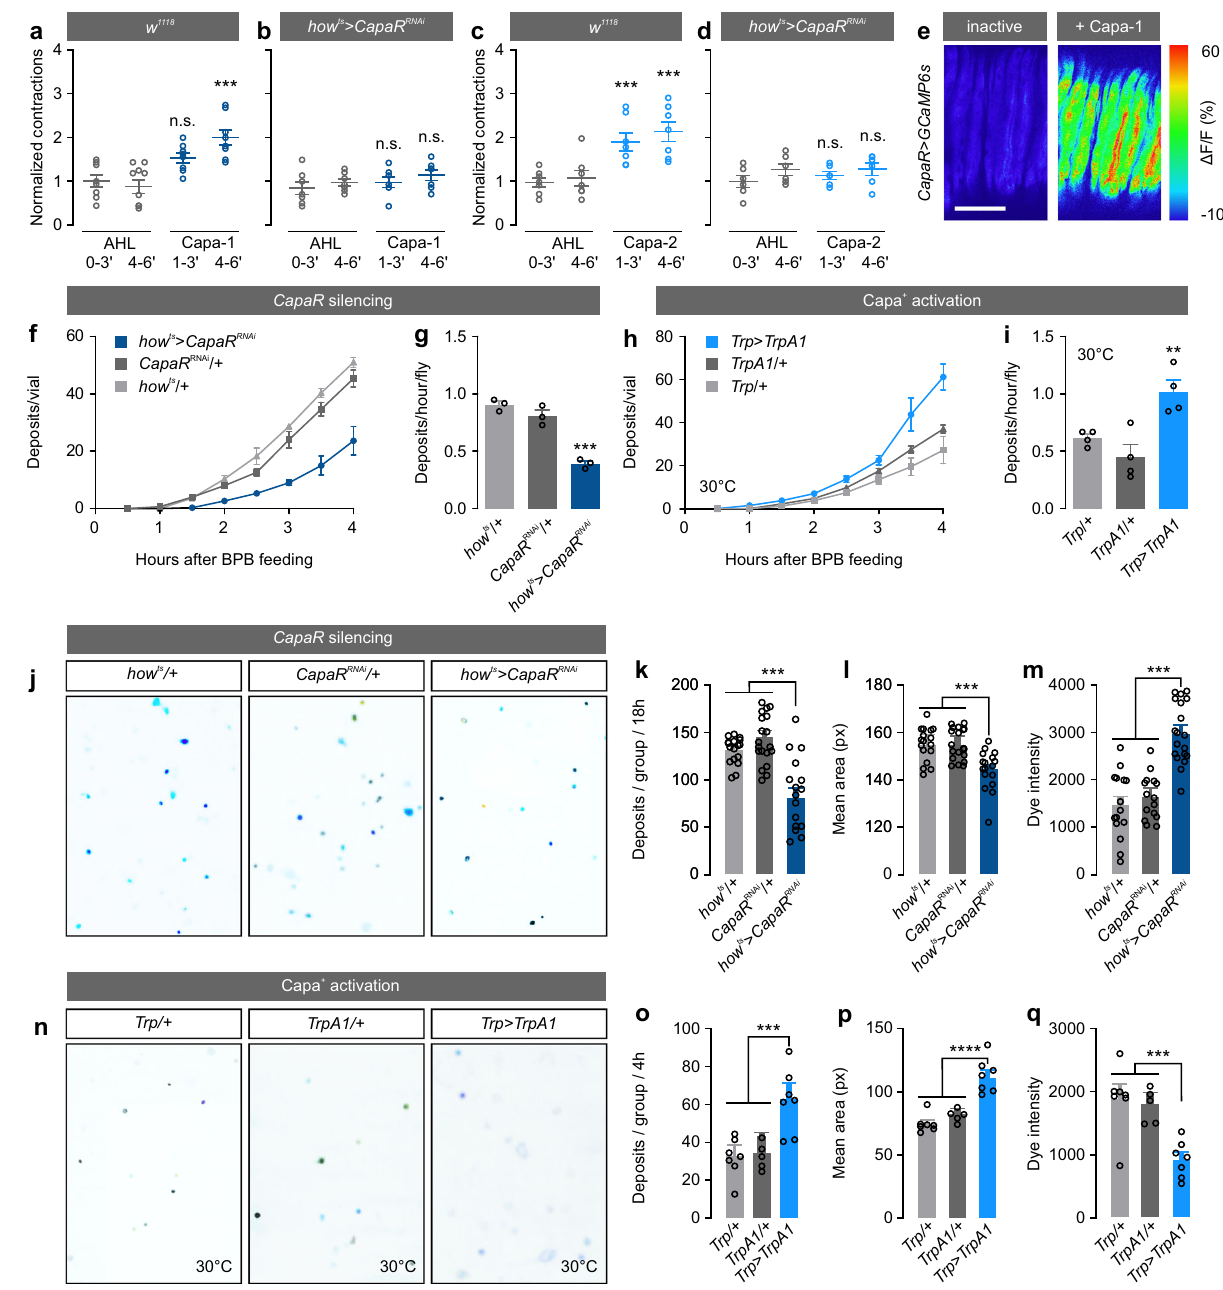
Fig. 4 Capa modulates intestinal contractions and excretory physiology. a – d Spontaneous gut contractions from w 1118 and muscle-speci fi c CapaR knockdown fl ies ( how ts > CapaR RNAi ) in response to arti fi cial hemolymph (AHL) and AHL containing a , b Capa-1 or c , d Capa-2 at a concentration of 10 − 7 M. Gray values indicate exposures to AHL alone, whereas colored values refer to exposures to AHL + Capa-1 or Capa-2. Δ Contractions were calculated by normalizing the number of contractions during Capa-1/-2 application over those in the control (one-way-ANOVA; a n = 8, P < 0.0003; b n = 7, P > 0.05; c n = 7, P < 0.001; d n = 6, P > 0.05). e Inactive and activated circular visceral muscles in guts from fl ies expressing the GCaMP6s calcium sensor ( CapaR > GCaMP6s ) following Capa-1 stimulation. The experiment was repeated three times with corresponding results. Scale bar = 100 µ m. f Accumulated number of deposits and g the number of deposits/hour/ fl y in muscle-speci fi c CapaR silenced fl ies ( how ts > CapaR RNAi ) compared to parental controls (mean ± SEM; one-way-ANOVA; P < 0.001; n = 3 vials with 20 fl ies per vial). h Accumulated number of deposits, i the number of deposits/hour/ fl y in fl ies with arti fi cial activation of the Capa + neurons by ectopic expression of the heat-sensitive TrpA1 channel ( Trp > TrpA1 ) compared to control fl ies at 30 °C (mean ± SEM; one-way-ANOVA; P = 0.0033; n = 3 biologically independent replicates with 20 fl ies per replicate). j , n Representative fecal output pro fi les from the different genetic manipulations fed on BPB-labeled food. Muscle-speci fi c silencing of Capa/CapaR signaling ( how ts > CapaR RNAi ) results in k fewer, l smaller, and m more concentrated BPB-labeled deposits compared to the parental controls (mean ± SEM; one-way-ANOVA; k n = 17, P < 0.001; l n = 17, P = 0.003, m n = 15, P < 0.001; n-numbers refer to biologically independent replicates with 10 fl ies per replicate). o Conversely, overactivation of Capa-producing neurons ( Trp > TrpA1 ) induced excretion of more ( P = 0.0006), p larger ( P < 0.0001), and q lighter deposits ( P < 0.0006) compared to fl ies carrying each transgene alone (mean ± SEM; one-way-ANOVA; n = 5 biologically independent replicates with 10 fl ies per